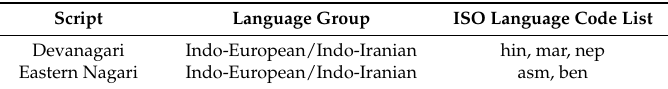
Table 5. Nagari and Devanagari script